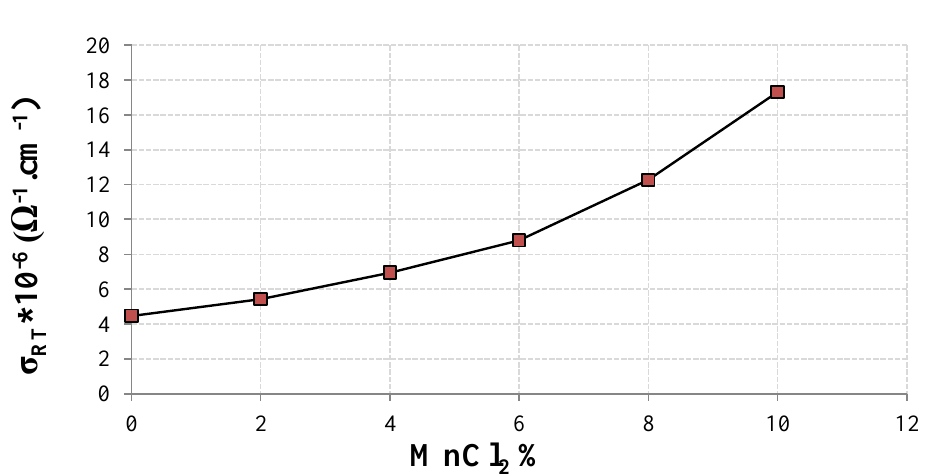
Fig.1: D.C conductivity with different concentration of MnCl